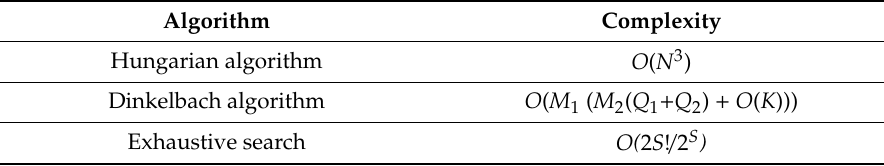
Table 3. The complexity comparison between the proposed and existing algorithms.